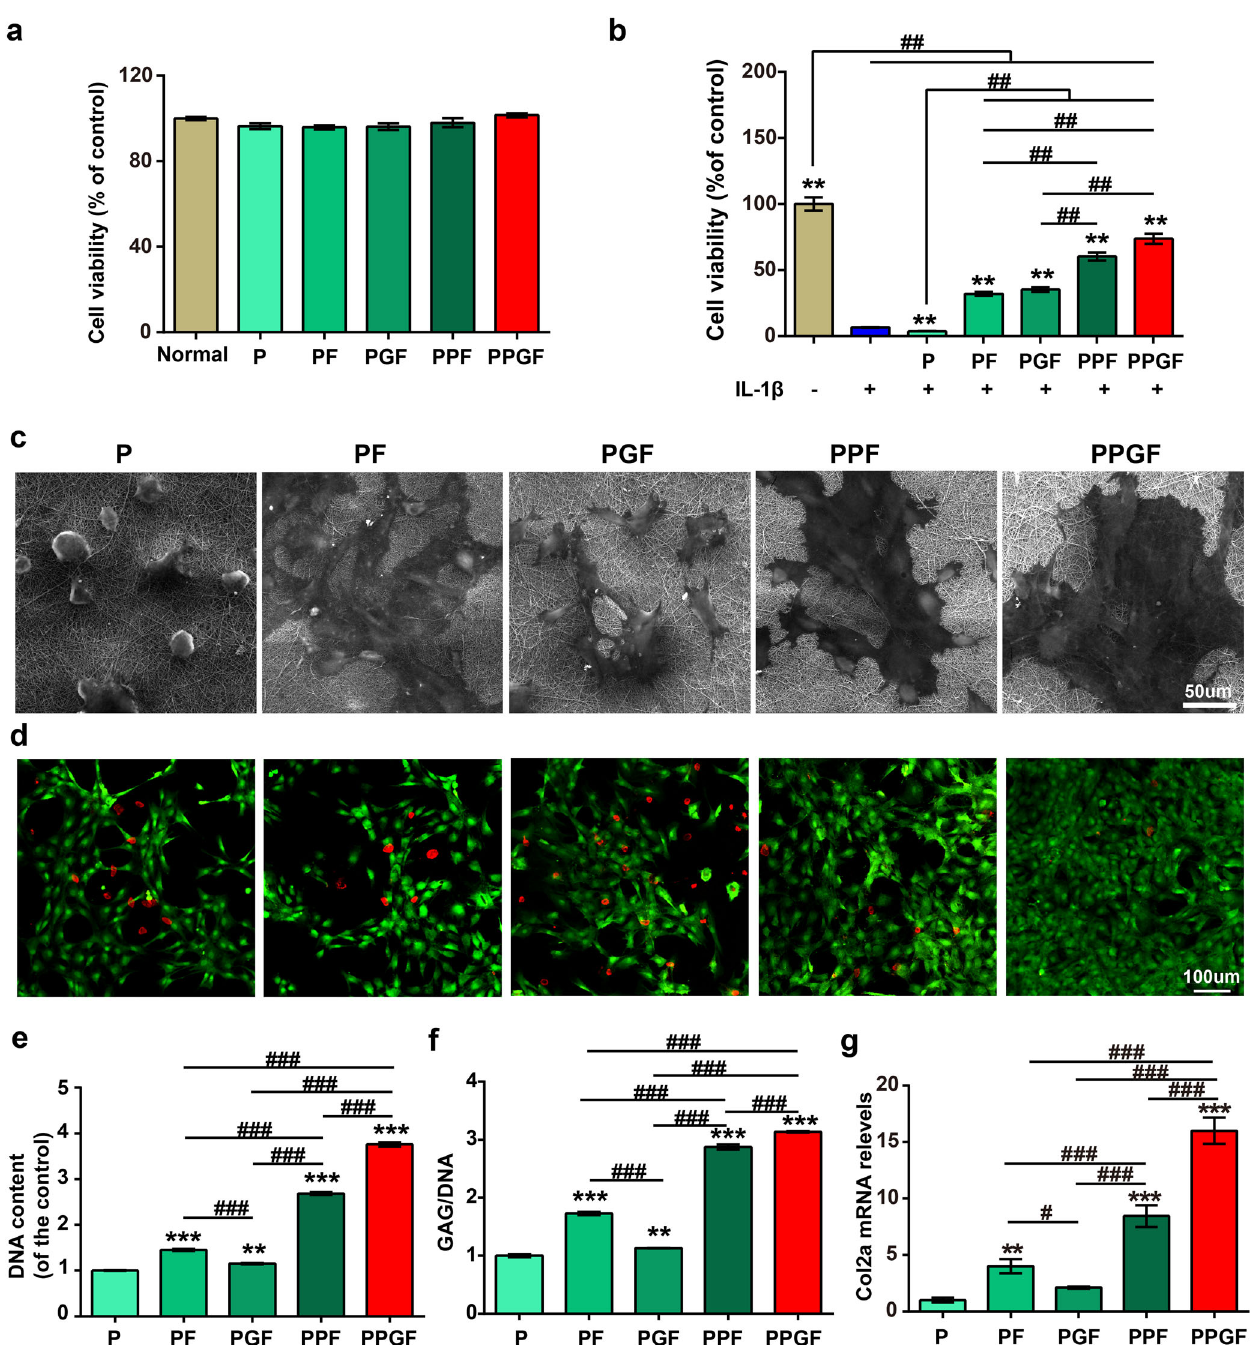
Fig. 5 Chondroprotective effects of nano fi ber membranes on IL-1 β stimulated chondrocytes. a , b Cell viability of chondrocytes cultured on different nano fi ber membranes in the stimulation with or without IL-1 β (** , ## means p < 0.001, * is the statistical difference compared with IL- 1 β group and # is the statistical difference between the pairwise comparison). c Cell attachment of chondrocytes cultured on different nano fi ber membranes (Scale bars, 50 µm). d Live/dead assay of chondrocytes cultured on different nano fi ber membranes after induced by IL- 1 β (Scale bars, 100 µm). e DNA and f GAG contents of chondrocytes cultured on different nano fi ber membranes after being induced by IL-1 β . g Relative mRNA expression levels of Col2a1 of chondrocytes cultured on different nano fi brous membranes after induced by IL-1 β . The values were presented as the mean ± SD ( n = 3; statistics: one-way ANOVA;* , # means p < 0.05, ** , ## means p < 0.01, *** , ### means p < 0.001, * is the statistical difference between the P and Fx-loaded groups, and # is the statistical difference between the pairwise comparison among the Fx- loaded